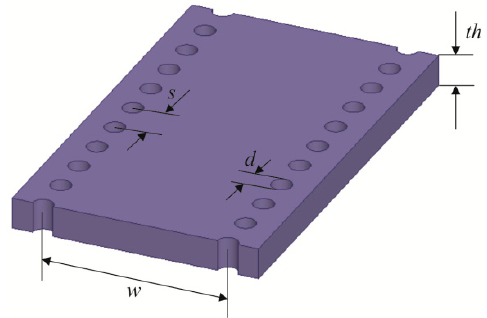
Figure 1. Sketch of a substrate integrated waveguide (SIW).